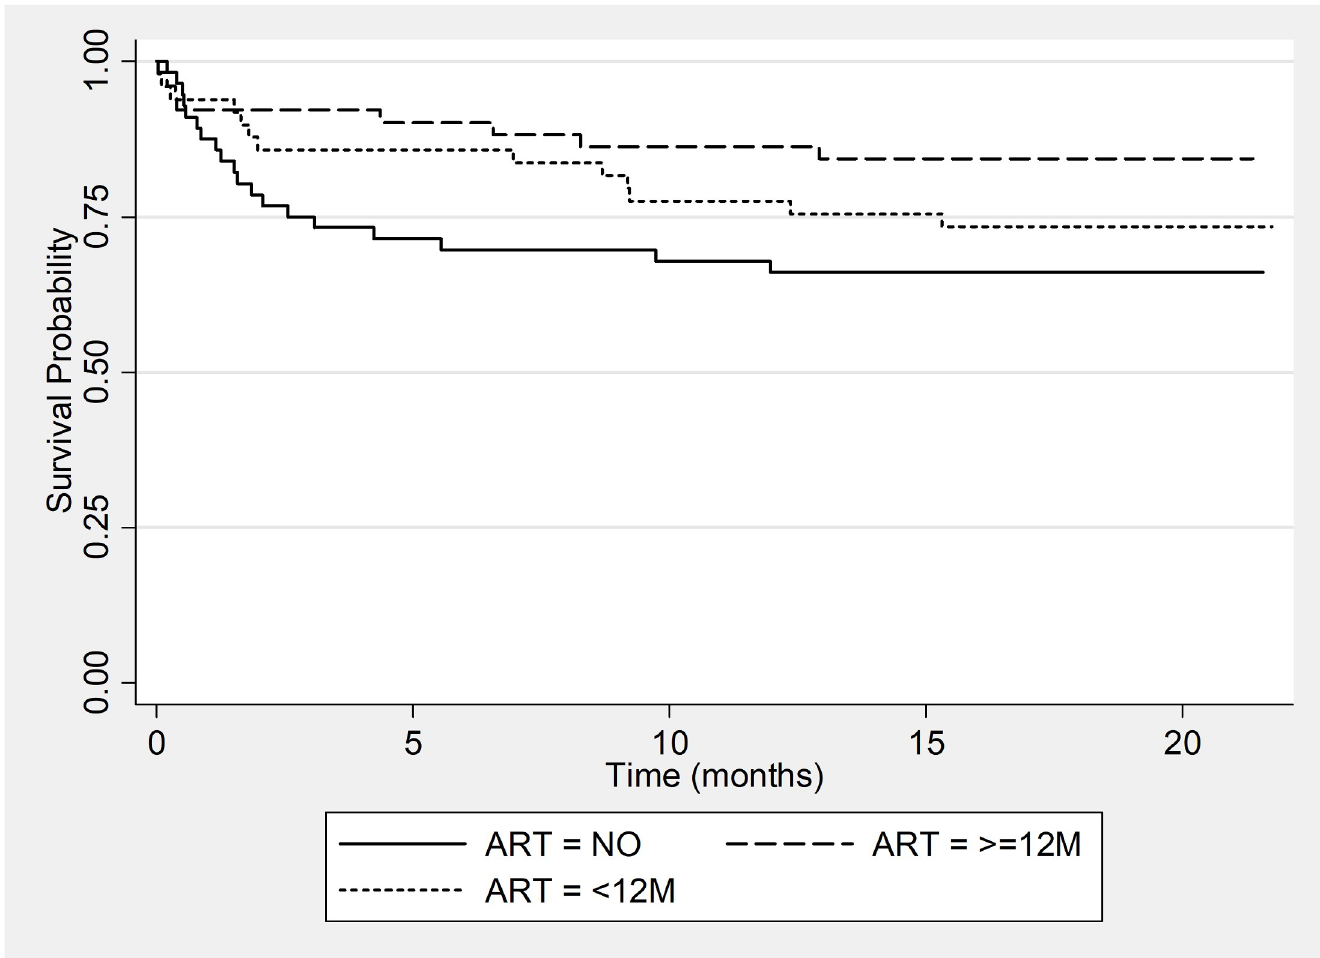
Fig 4. Kaplan-Meier survival estimates for unfavorable outcomes among HIV positive patients by ART status.